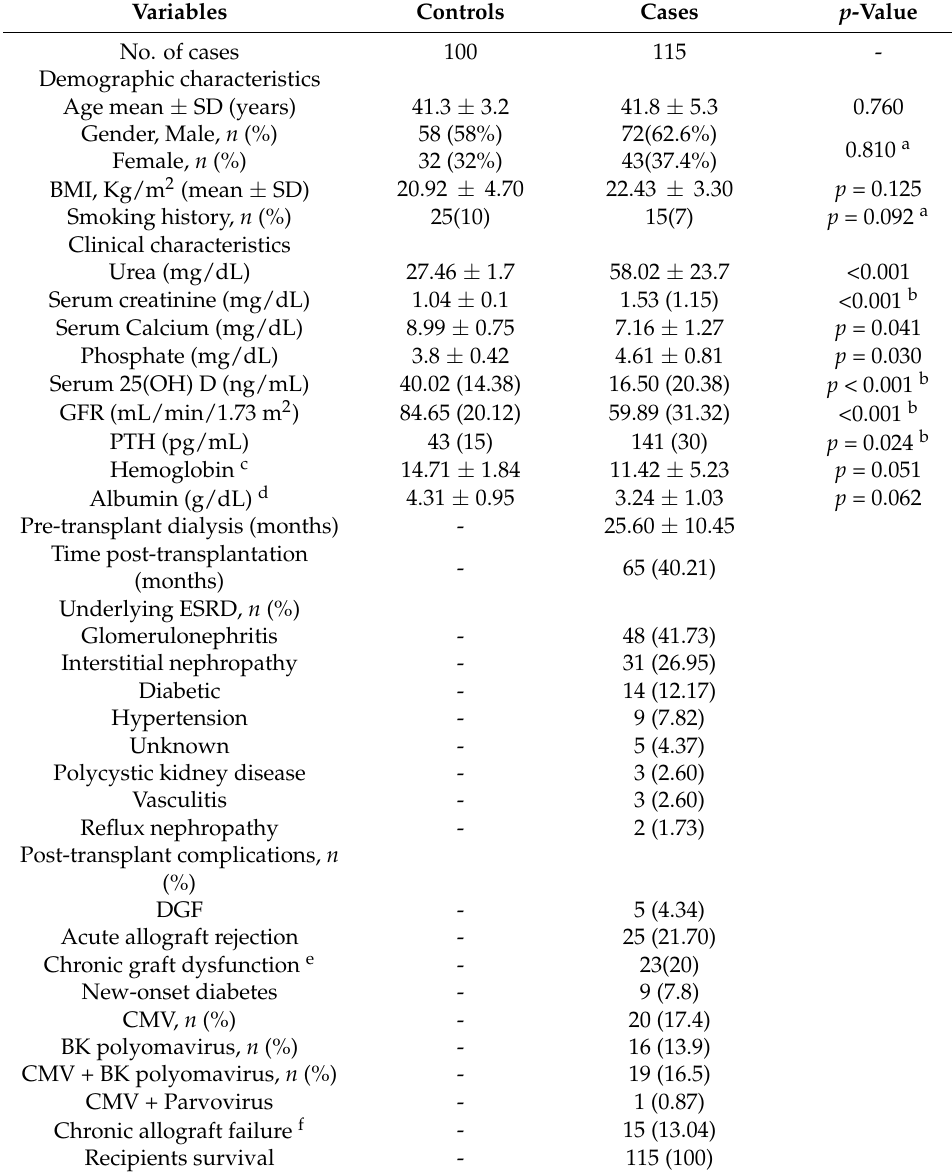
Table 2. Demographic and baseline clinical